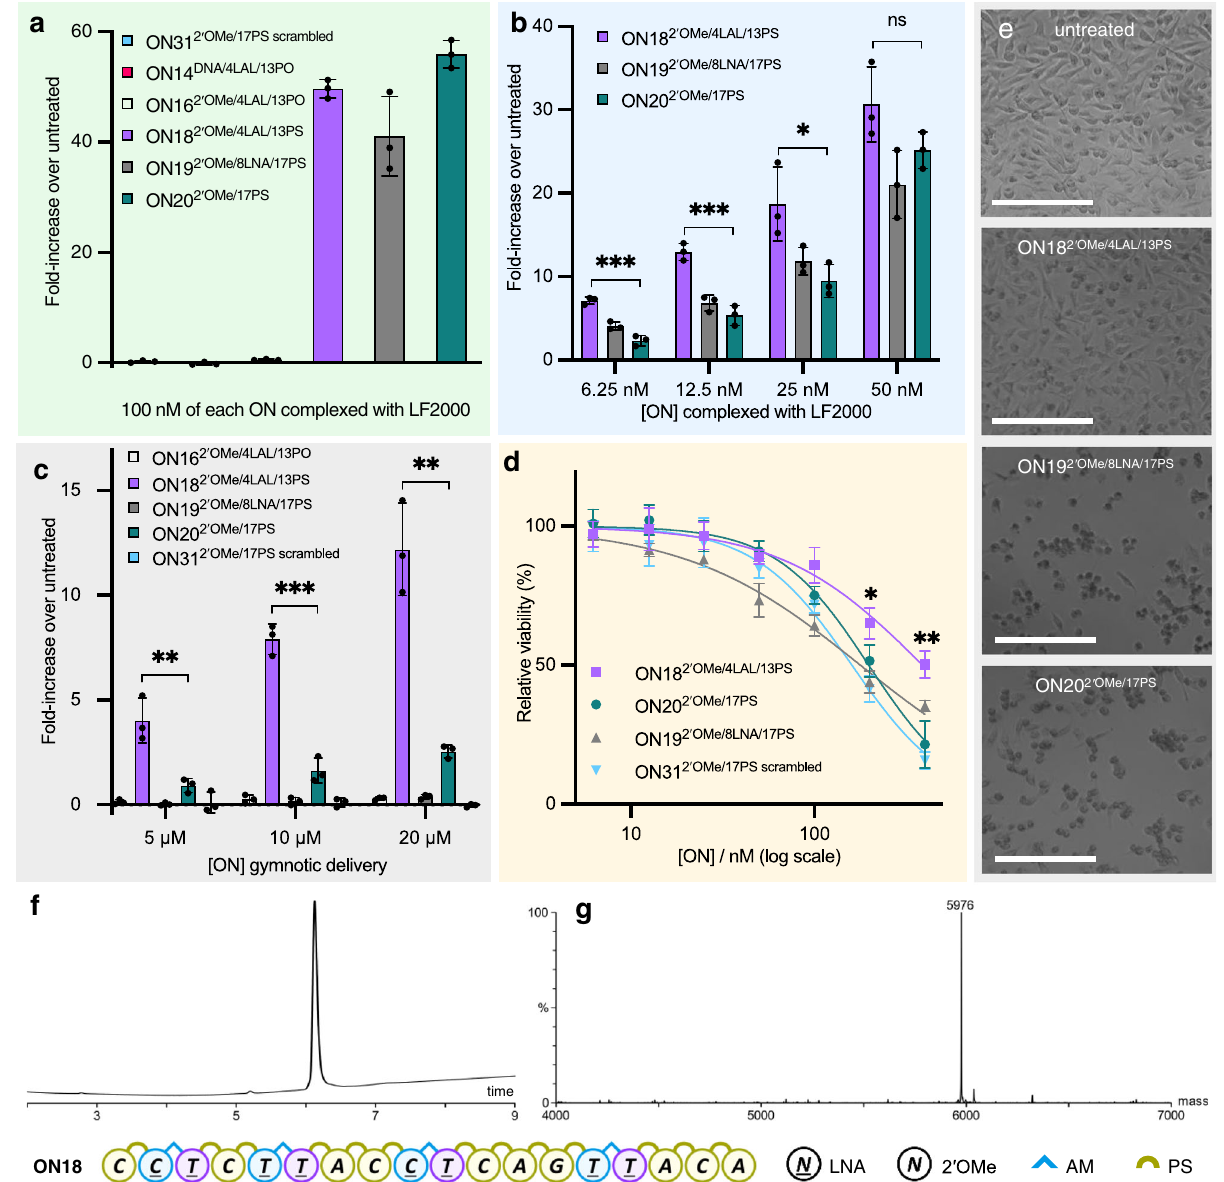
Fig. 6 LNA- fl anked amides and PS linkages increase gymnotic delivery, exon-skipping activity and reduce toxicity. In all cases, luciferase activity was measured and normalised to both protein quantity and untreated cells. Experimental details and sequences are given in the Supplementary Information. a HeLa pLuc/705 cells were transfected at 100 nM ON using LF2000. b Dose-response for active ONs in a . c Cells were treated with ONs without a transfection agent. d Viability of the HeLa pLuc/705 cells following lipofection with ONs using LF2000 determined using WST-1 assay. For all graphs ( a – d ) data were means ± SD and values for ON18 2 ′ OMe/4LAL/13PS and ON20 2 ′ OMe/17PS were compared using unpaired two-sided t -test analysis. ns represents P > 0.05, *represents P < 0.05, **represents P < 0.01, ***represents P < 0.001. Each dot represents one distinct replicate ( n = 3). ON31 2 ′ OMe/17PS scrambled : CCUCAUUCACUCGAUUCA. e Change in cell viability after treatment with 200 nM ONs complexed with LF2000 compared to untreated, scale bar = 200 μ m. Micrographs of cells shown are the representations from ≥ 10 images taken per condition. f Reversed-phase HPLC chromatogram and g . Electrospray (ES-) mass spectrum of puri fi ed ON18 used in the assays (required mass = 5976.2, found mass = 5975.5). Source data are provided in the Source Data fi